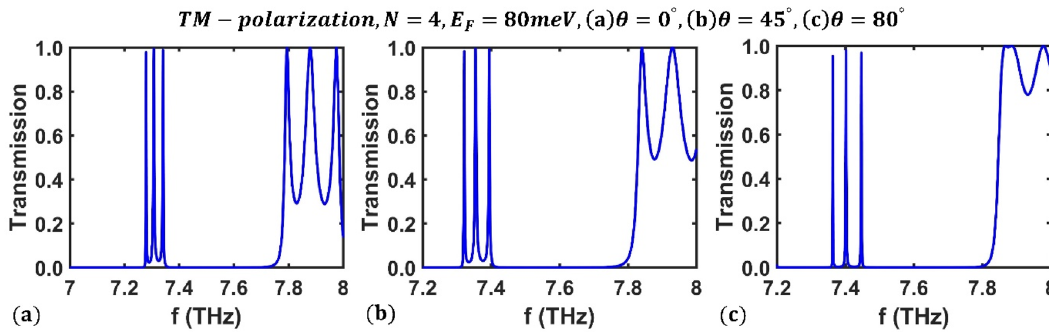
Figure 11. The transmission spectrum of the third-order F-1D PhC for TM polarization state corresponding to fixed values of Fermi energy and period number as E F = 80 meV and N = 4 , respectively, under different light ◦ ◦ ◦ incident angles ( a ) θ = 0 , ( b ) θ = 45 and ( c ) θ = 80